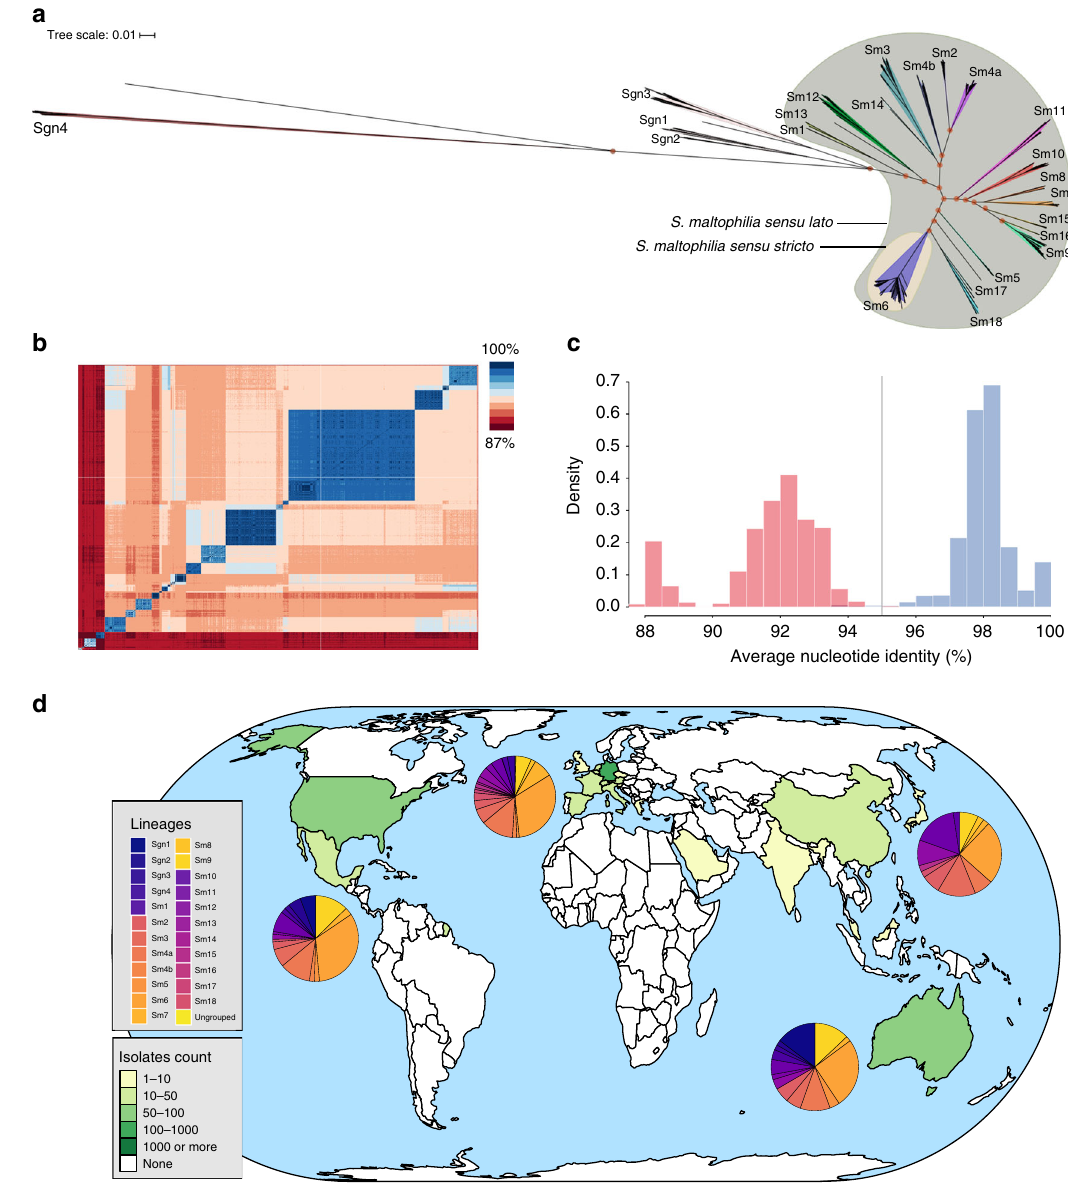
Fig. 1 The global population structure of the S . maltophilia complex is composed of 23 monophyletic, globally distributed lineages. a Unrooted maximum likelihood phylogenetic tree of 1305 S. maltophilia strains displaying the known population diversity of the S. maltophilia complex. The tree was built using RAxML on the sequences of 1275 concatenated core genome genes. Groups as de fi ned by hierarchical Bayesian clustering are marked with shaded colours, and group numbers are indicated at the tree leafs of each corresponding group. orange shading = S. maltophilia sensu stricto ; green shading = S. maltophilia sensu lato ; 100% support values for the main branches are indicated with red circles. b Pairwise average nucleotide identity comparison calculated for 1305 S. maltophilia strains shown on a heatmap with blue indicating high and red indicating low nucleotide identity. c Histogram of pairwise average nucleotide identity (ANI) values, illustrating that strains of the same lineage are highly similar at the nucleotide level with ANI values above 95% (depicted in blue). Inter-lineage comparisons (in red colour) reveal low genetic identity between strains. The currently accepted species delimitation threshold at 95% is shown as a grey vertical line. d Geographic origin of the 1305 S. maltophilia strains comprising the study collection indicated on a global map. The green/ yellow colour code indicates the number of strains obtained per country. The distribution of phylogenetic lineages per continent is displayed as colour-coded pie charts. The map was created using the tmap package in R 69 . Source data are provided as Source Data